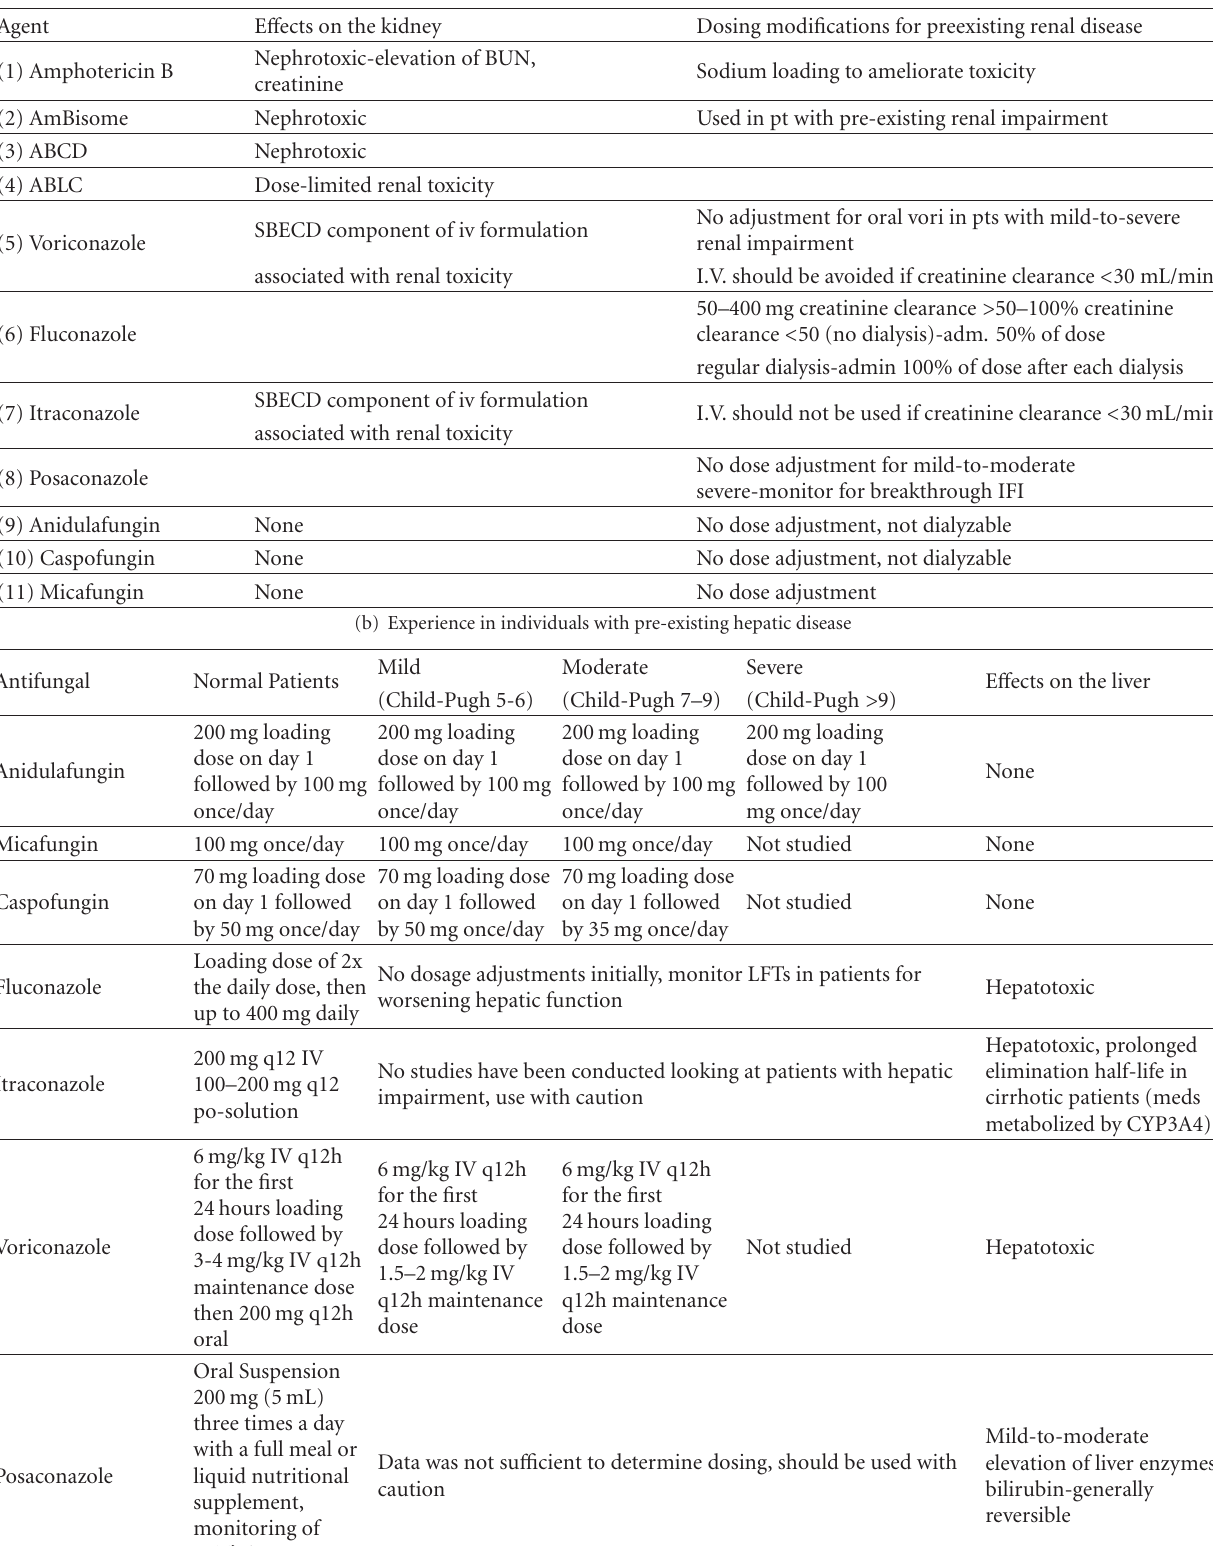
(a) Experience in patients with prexisting renal disease Dosing modifications for preexisting renal